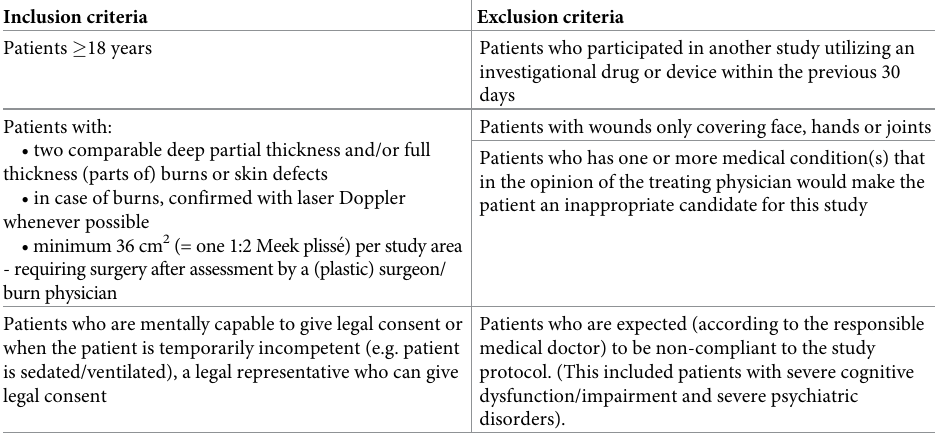
Table 1. In- and exclusion criteria for enrollment in this study.